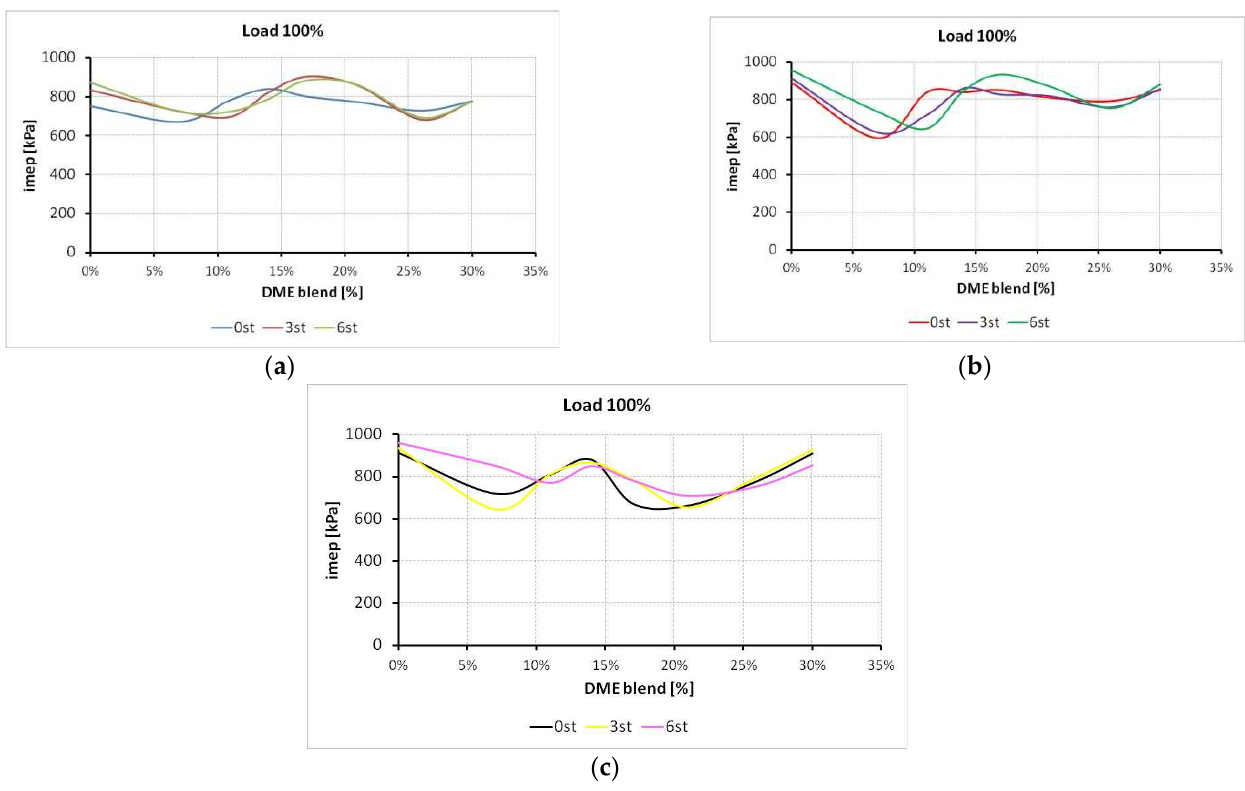
Figure 6. Imep value for three speeds: ( a ) 2000 rpm, ( b ) 2500 rpm, and ( c ) 3000 rpm.